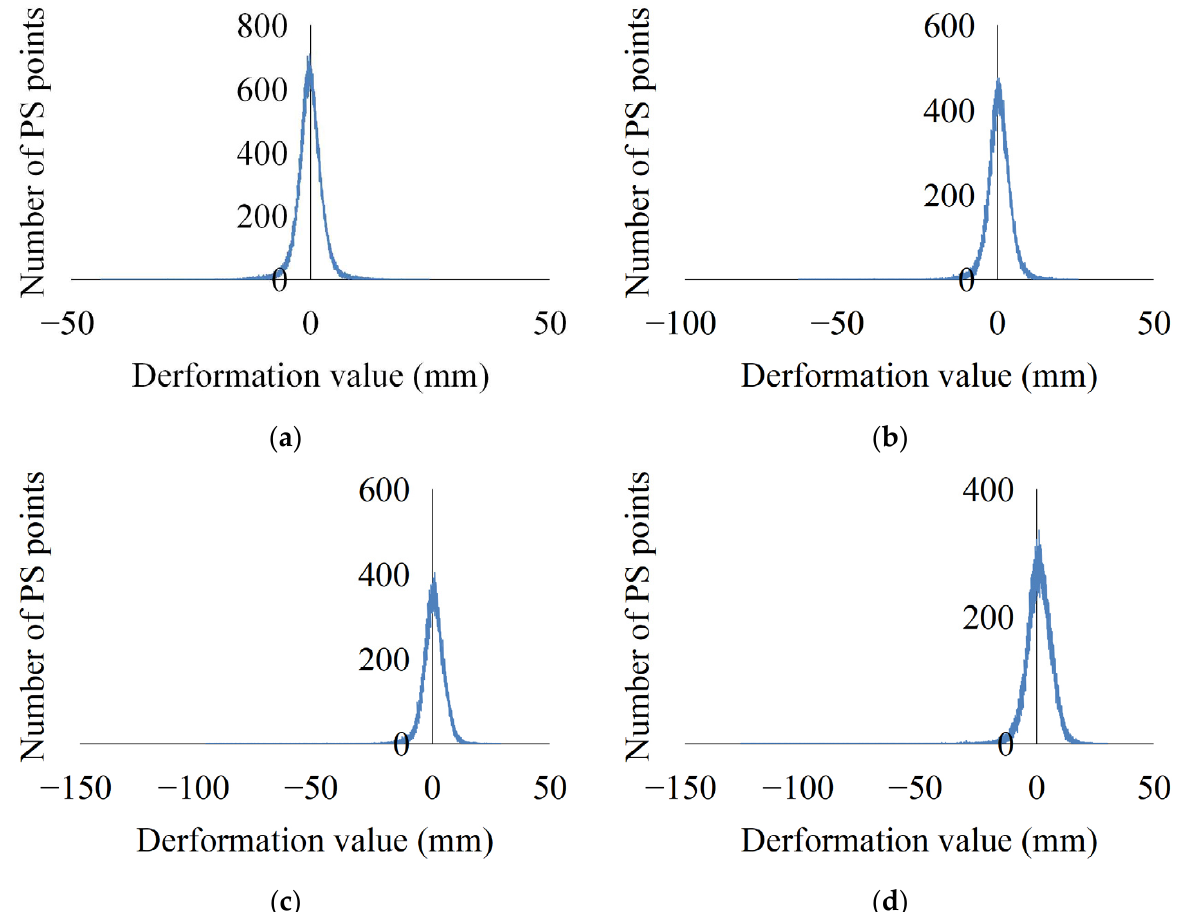
Figure 5. Statistics of the deformation values: ( a ) April–December 2017; ( b ) April 2017–December 2018; ( c ) April 2017–December 2019; and ( d ) April 2017–December 2020.